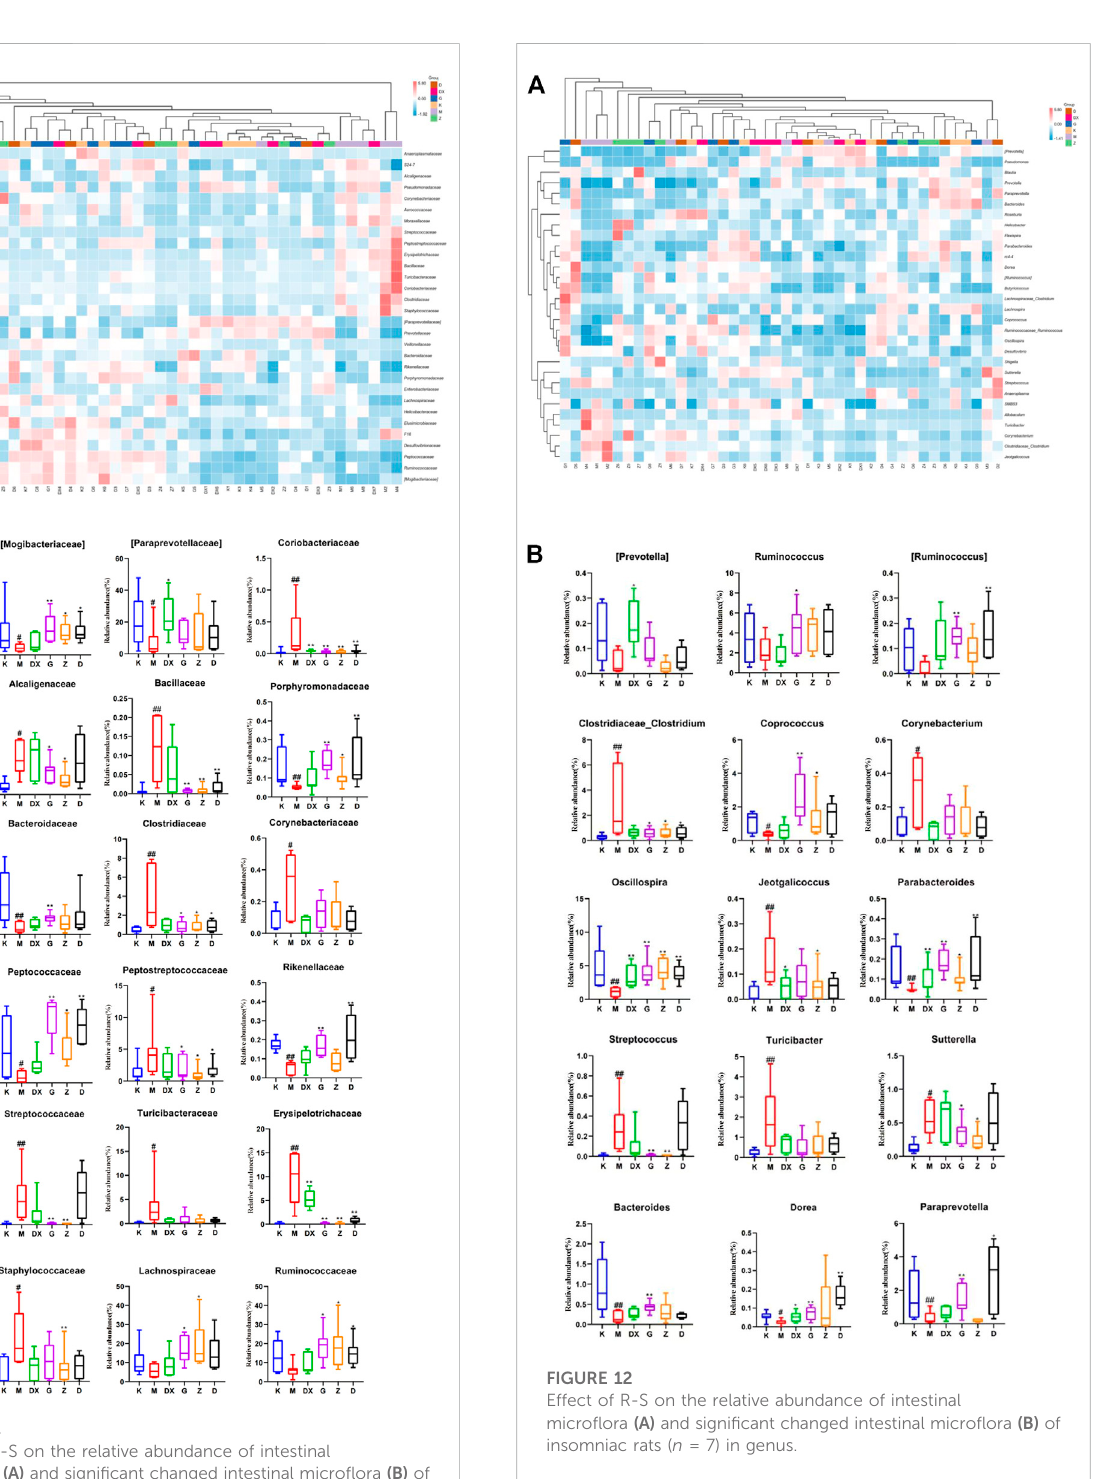
difference. The relative abundance of Clostridium, Turicibacter, Jeotgalicoccus, Corynebacterium, Allobaculum, Sutterella, and Streptococcus was higher ( p < 0.05, p < 0.01). Compared with the model group, the relative abundance of Prevotella, Paraprevotella,